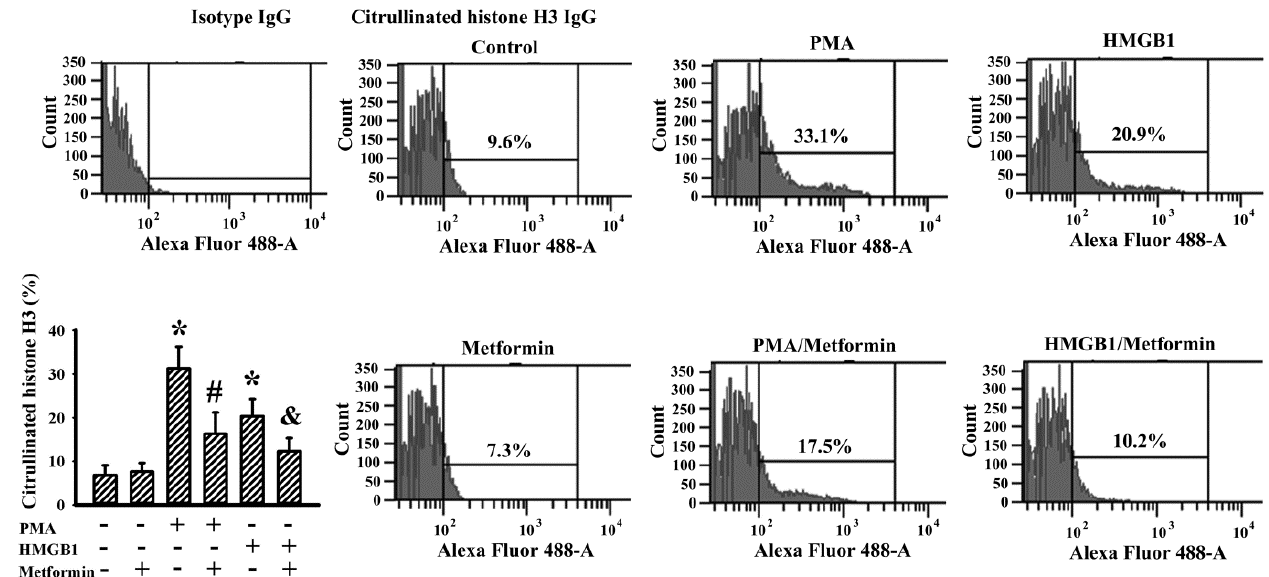
Figure 9. Metformin decreased NETs induction in human neutrophils. Human neutrophils were treated with a vehicle (Control), PMA (100 nM), HMGB1 (1 µ g/mL), metformin (500 µ M) or in combinations as indicated for 3 h. The treated neutrophils were subjected to flowcytometric analysis for the measurement of citrullinated histone H3 positivity with an indicated primary antibody and an Alexa Fluor 488-labeled secondary antibody. Control isotype IgG was used for the purpose of background calibration. Representative plots and quantitative data are shown. * p < 0.05 vs. untreated group, # p < 0.05 vs. PMA group, and & p < 0.05 vs. HMGB1 group, n = 3.